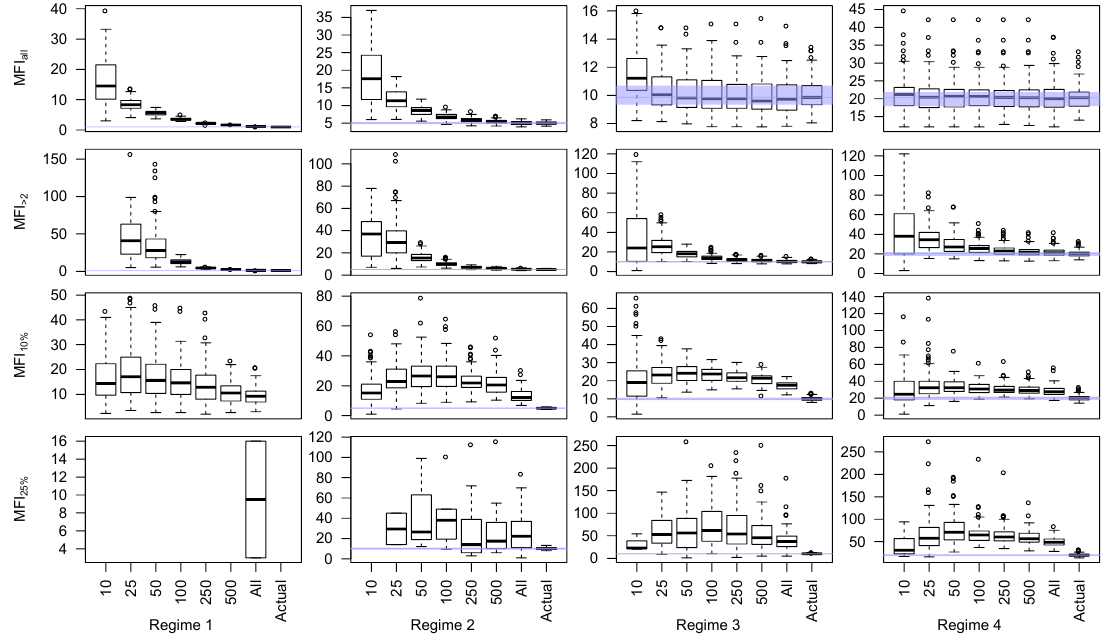
Figure 2. Box and whisker plots of tree-ring reconstructed MFI measurements (y-axes) by fire regime (columns), filter level (rows), and by sample size (x-axes) for probabilistic sampling strategies. The shaded region is the range of actual fire-intervals experienced across all 100 simulations for that fire regime. Note that it takes larger sample sizes to accurately describe the fire regime using a probabilistic sampling strategy than a targeted one (Figure 1). Note also that when filtering the fire-scar record at 10% or 25% level, probabilistic sampling regimes never accurately describe any of the fire